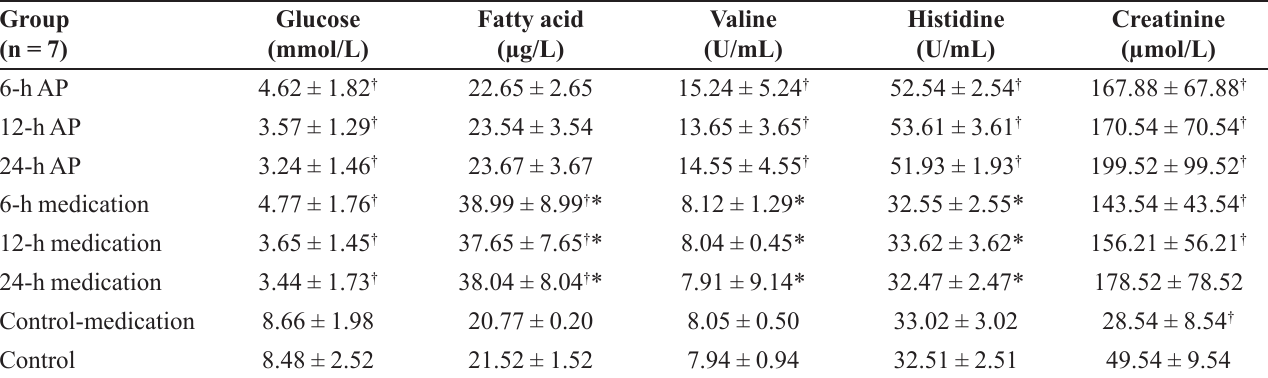
* p < 0.05 for comparison between the corresponding groups (6-h AP group vs 6-h medication group; 12-h AP group vs 12-h medication group; 24-h AP group vs 24-h medication group). † p < 0.05 vs control